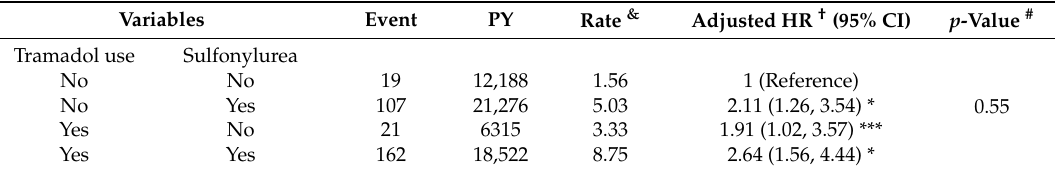
Table 4. Cox proportional hazard regression analysis for the risk of hypoglycemia-associated tramadol use with joint effect of